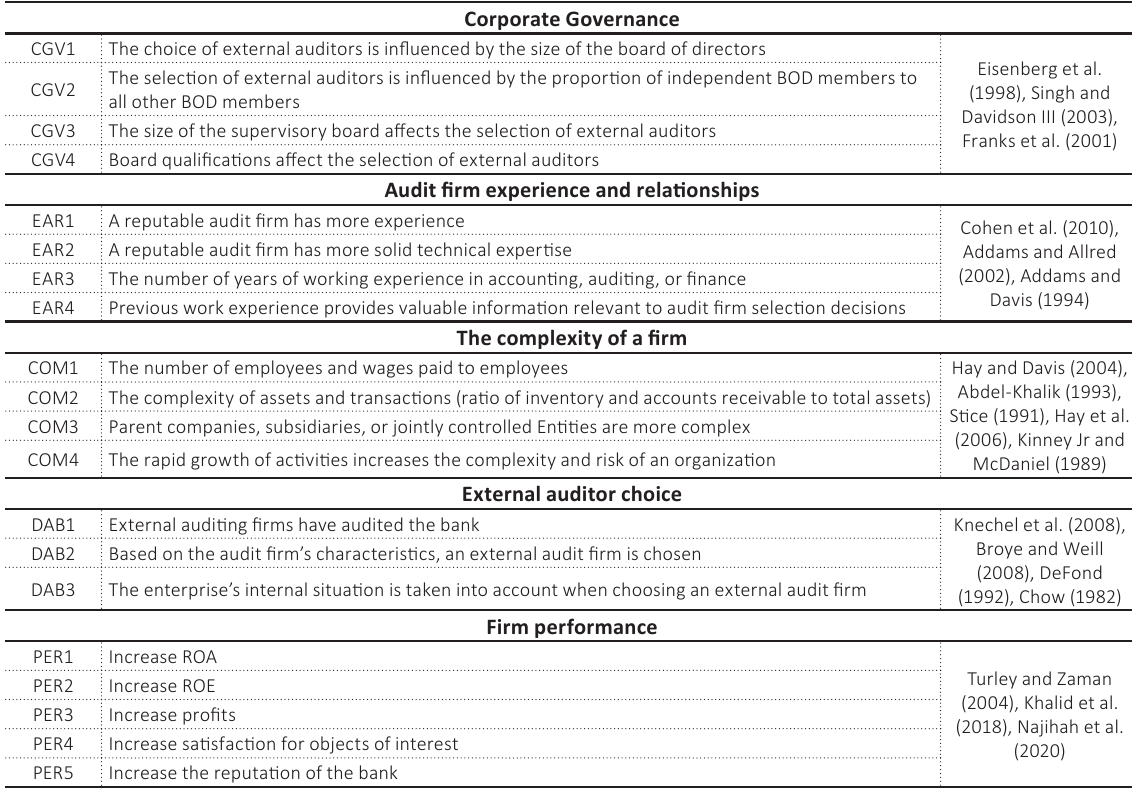
Table 2. Dimensions and